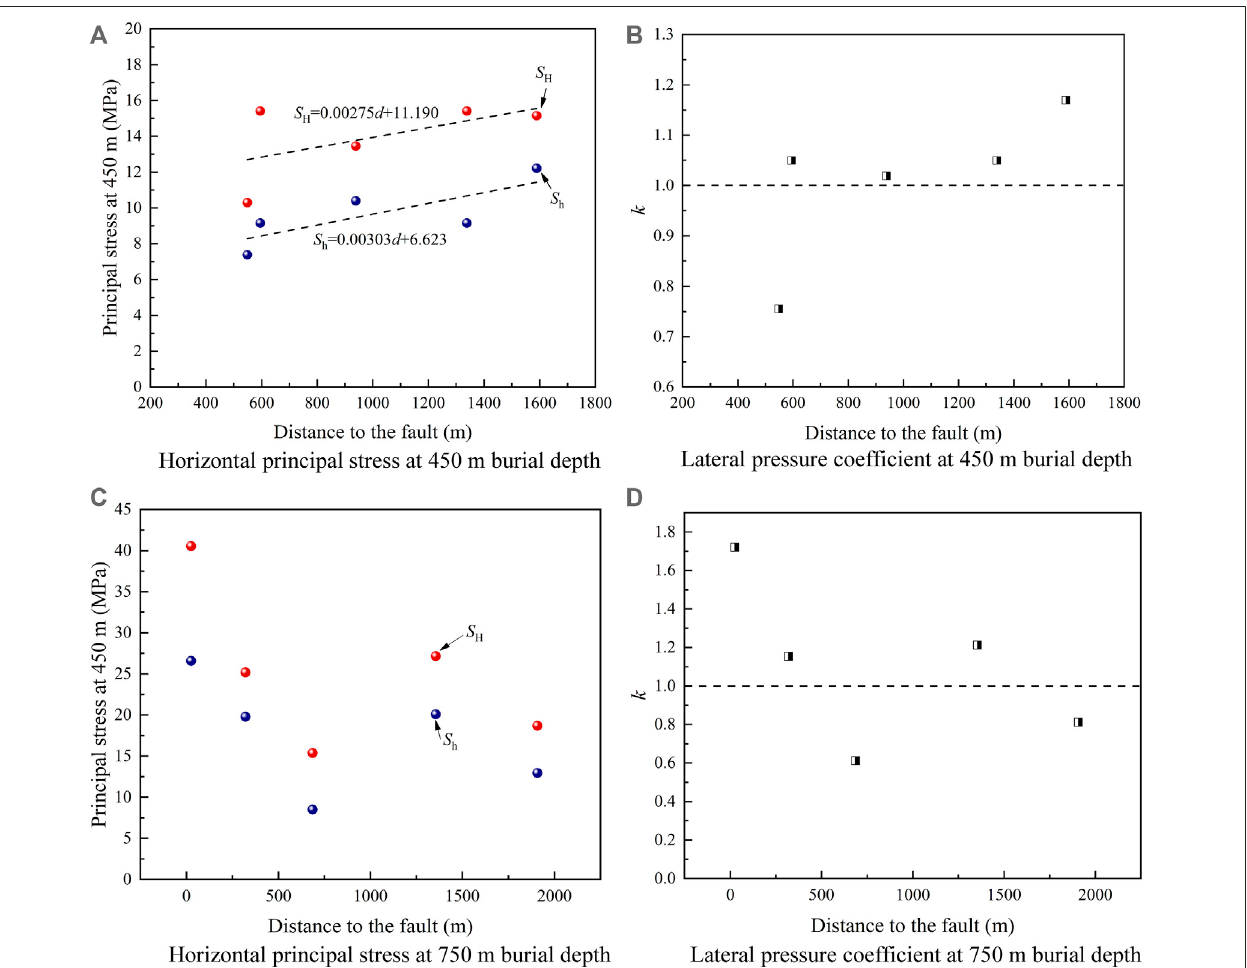
FIGURE 8 | The relationship between horizontal principal stress and lateral pressure coef fi cient of borehole and the distance to the fault (d represents the distance from borehole to fault) (A) Horizontal principal stress at 450 m burial depth (B) Lateral pressure coef fi cient at 450 m burial depth (C) Horizontal principal stress at 750 m burial depth (D) Lateral pressure coef fi cient at 750 m burial depth.